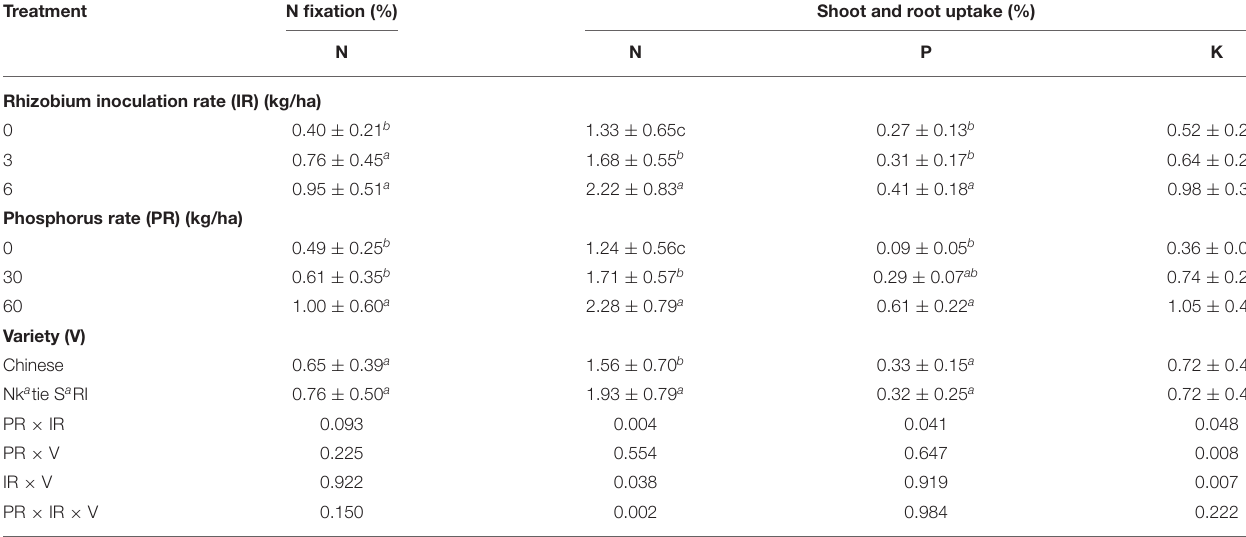
TABLE 6 | N fixation and N, P, and K uptake by groundnut as affected by variety, phosphorus, and rhizobium inoculation rates in the on-farm experiment. Treatment N fixation (%)